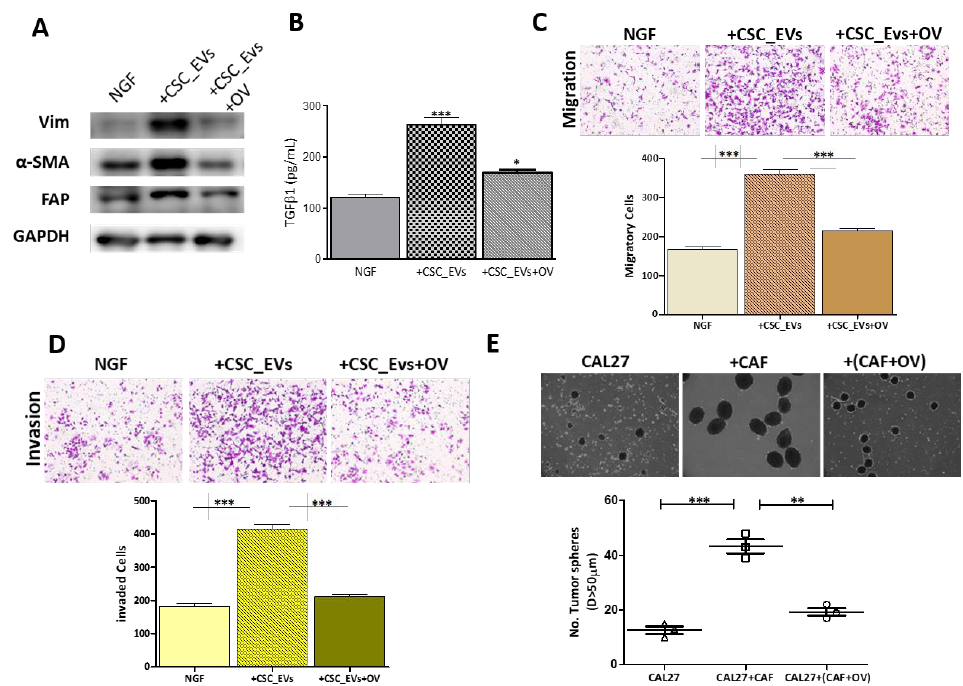
Figure 5. Ovatodiolide (OV) reduced cancer-associated fibroblast (CAF) transformation. ( A ) Western blots showed decreased levels of the CAF markers, fibronectin attachment protein (FAP), vimentin (Vim), and α-smooth muscle actin (α-SMA) in CAFs generated from cancer stem cell (CSC)_extracellular vesicles (EVs)+OV compared to ones cocultured with CSC_EVs. ( B ) The ELISA analysis showed that CAFs generated from normal gingival fibroblasts (NGFs) cocultured with CSC_EVs+OV secreted a significantly lower amount of transforming growth factor (TGF)-β1, compared to CAFs transformed from NGFs cocultured with CSC_EVs. ( C , D ) Migration and invasion assays demonstrated that CAFs generated from NGFs cocultured with CSC_EVs+OV had significantly lower migratory and invasive abilities, compared to their counterparts with CSC_EVs. ( E ) The tumor sphere formation assay indicated that CAL27 cells formed a significantly lower number of tumor spheres when cocultured with CAFs (CAFs+OV, transformed from NGFs, cocultured with CSC_EVs+OV). * p < 0.05; ** p < 0.01; *** p < 0.001.